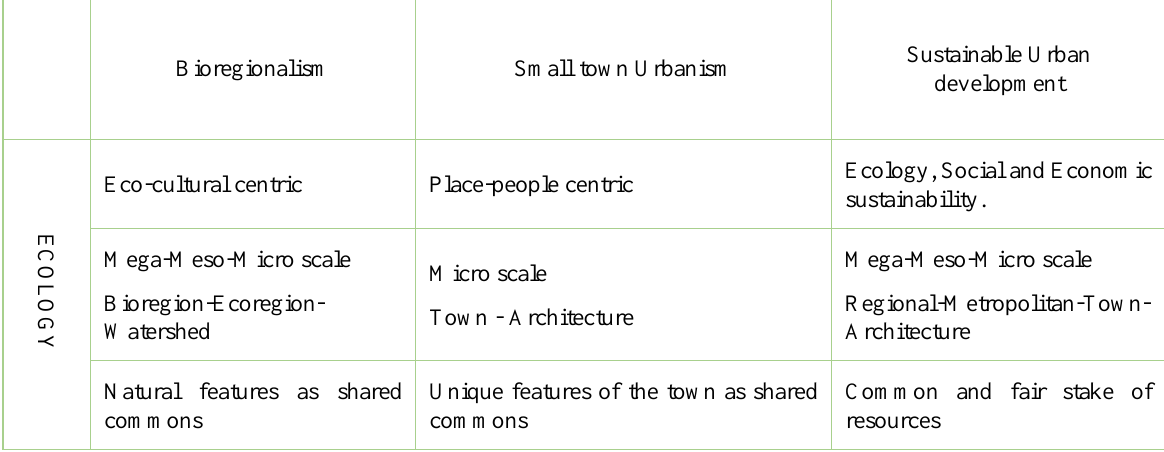
Table 1. Comprehensive relational framework of the theories.